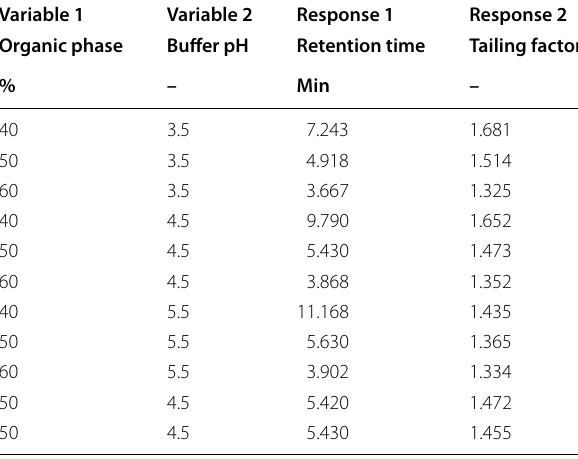
Table 1 Suggested experiments by design of experiments and